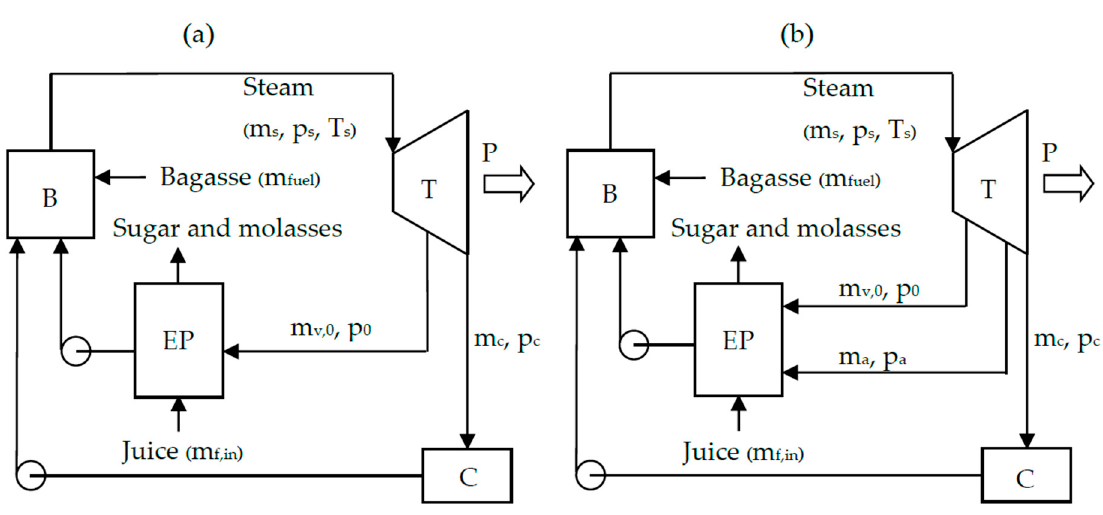
Figure 3. Cogeneration systems for ( a ) the conventional evaporation process and ( b ) the modified evaporation process .